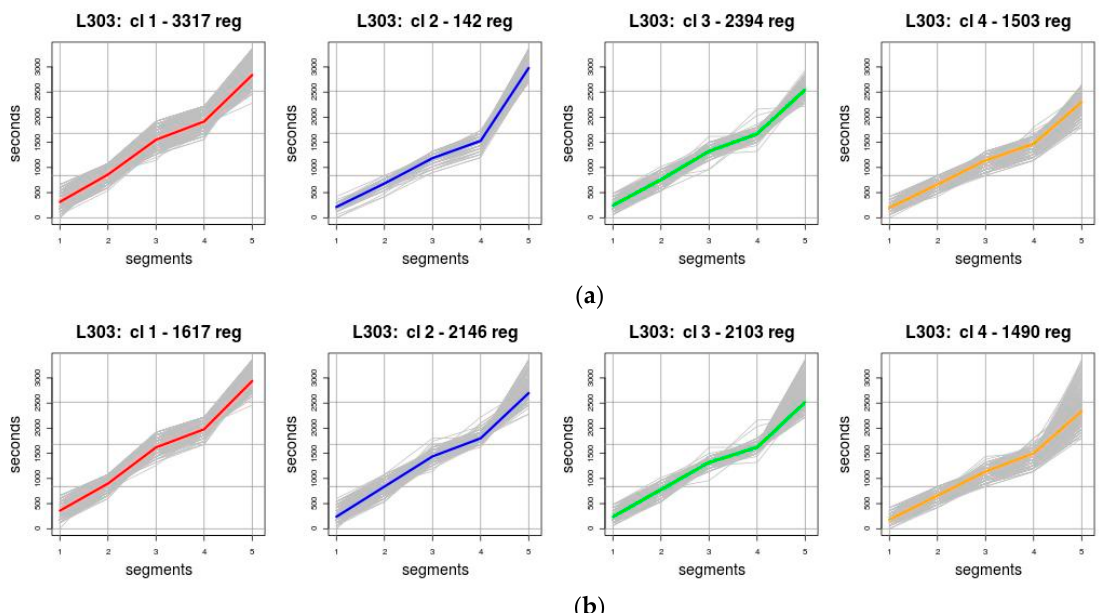
Figure 4. Clusters generated with four clusters with ( a ) Diana; ( b )